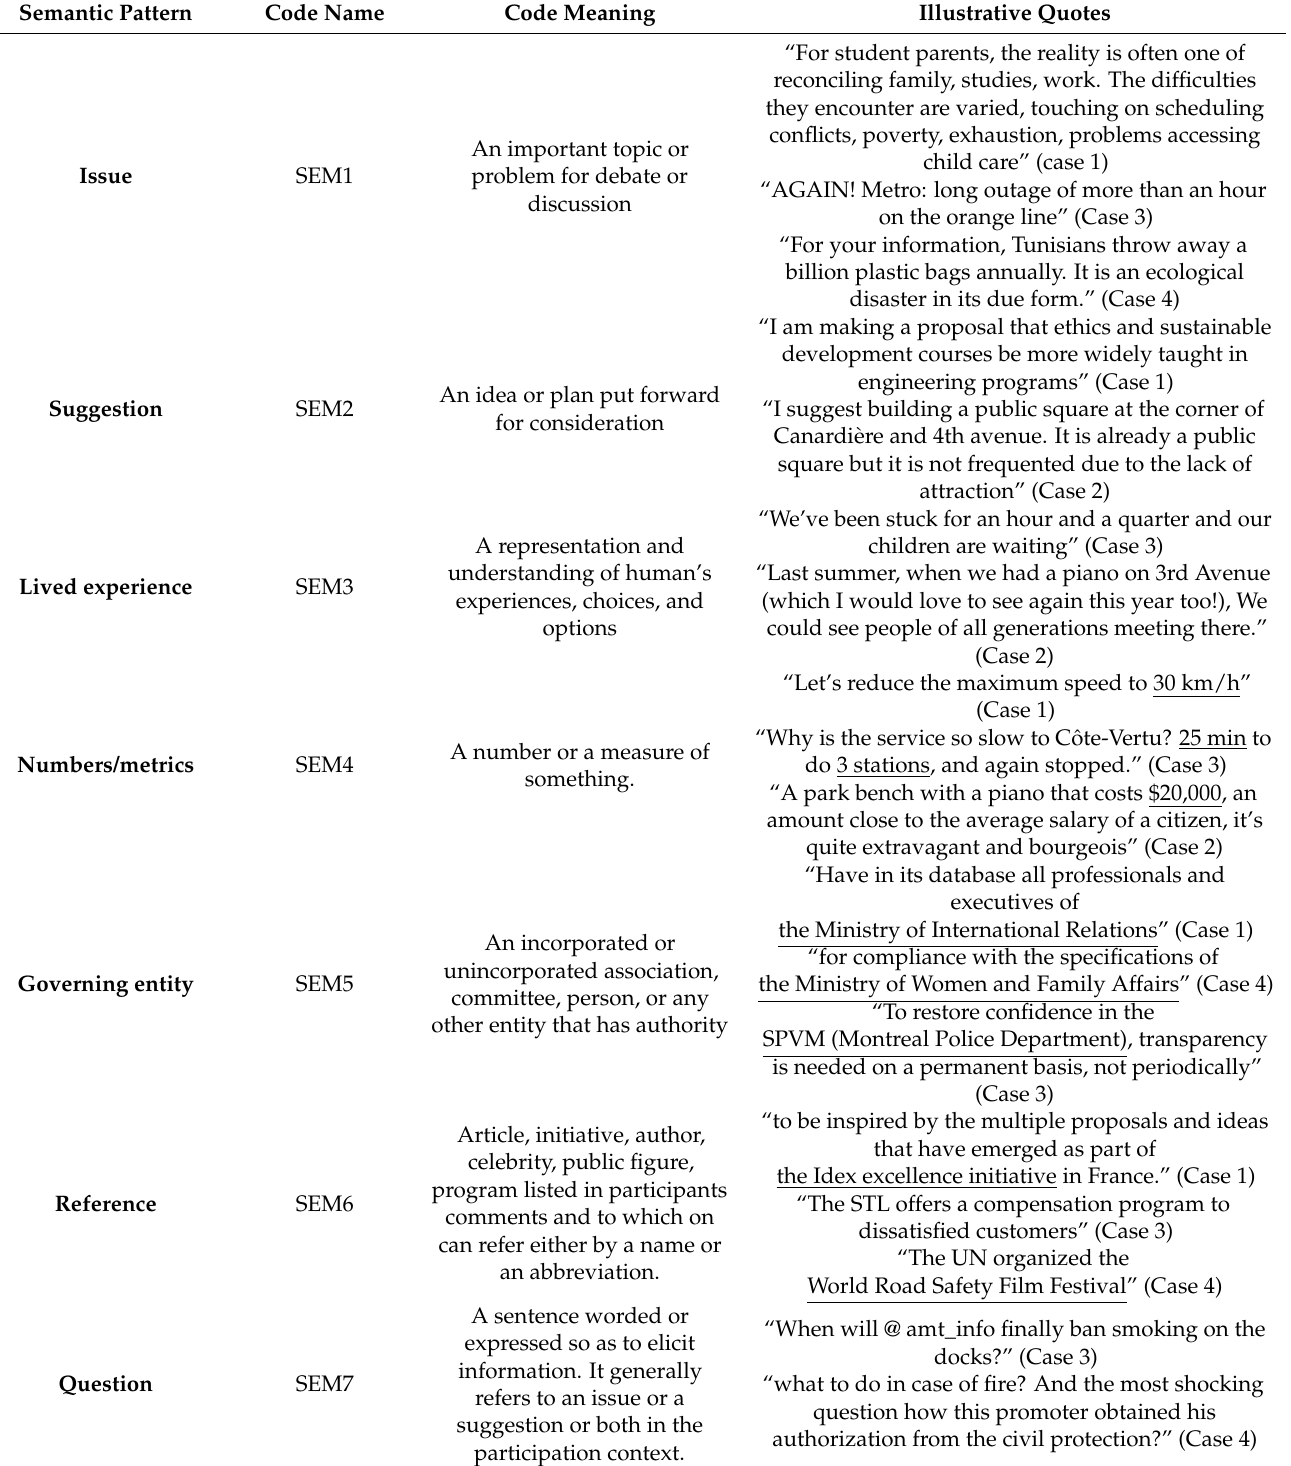
Table A2. Semantic Patterns in both online and offline SP